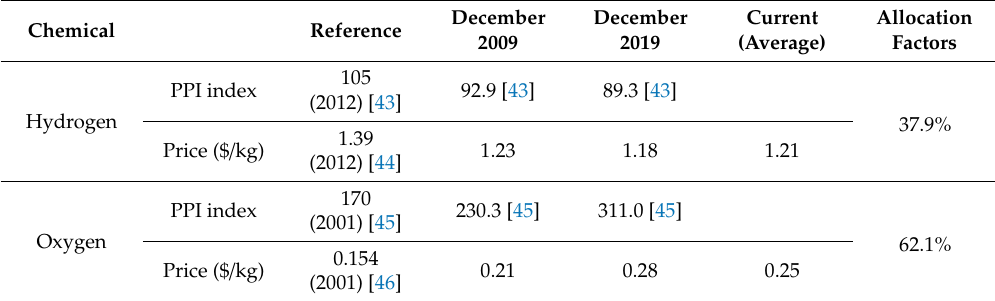
Table 4. PPI (Producer Price Index) and calculated average price for oxygen and hydrogen as bulk